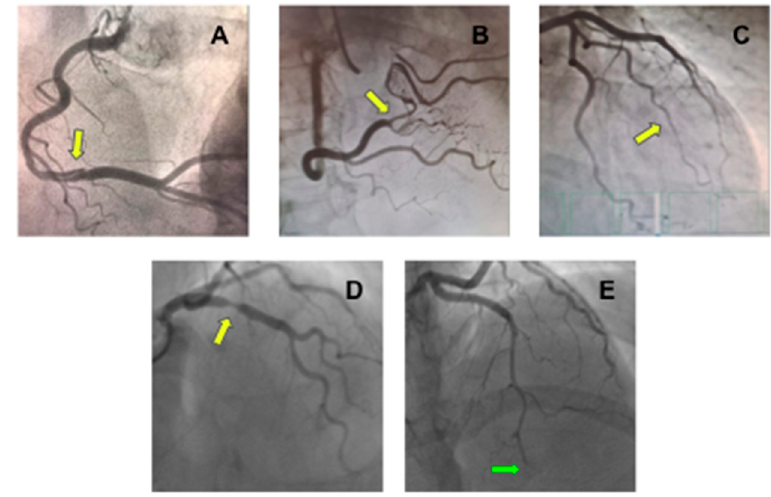
Figure 2. Coronary angiography showing different types of spontaneous coronary artery dissection (SCAD). ( A ) An image of double lumen at right coronary artery (yellow arrow) compatible with type 1 SCAD; ( B ) Stenosis at right coronary artery with distal vessel caliber normalization (yellow arrow) compatible with type 2A SCAD; ( C ) Long stenosis from mid-to-distal first marginal branch of the left circumflex coronary (yellow arrow) compatible with type 2B SCAD; ( D ) Focal stenosis at right coronary artery (yellow arrow) compatible at type 3 SCAD; and ( E ) Stenosis from mid-to-distal left anterior descending coronary artery (green arrow) with an abrupt total occlusion (green arrow) compatible with type 4 SCAD.